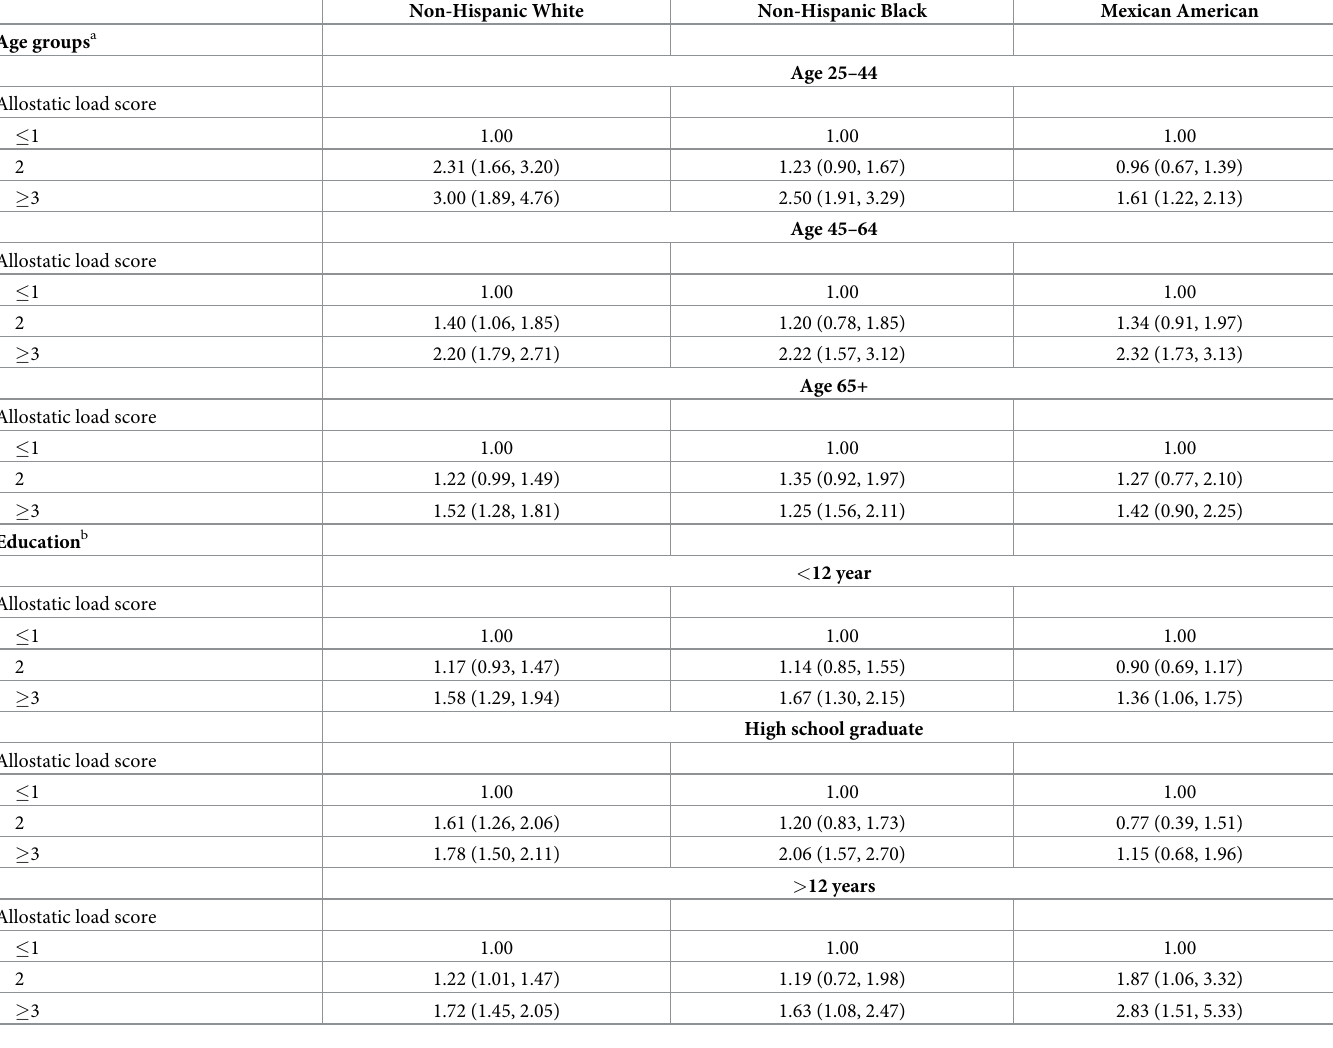
Table 6. Adjusted hazard ratios of all-cause mortality risk for allostatic load score categories for racial/ethnic groups according to age and education: NHANES III-- Linked Mortality File,